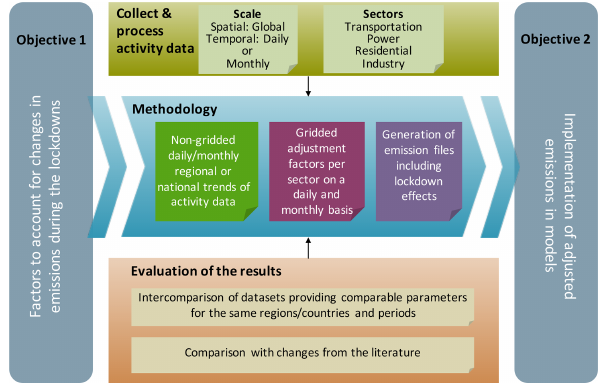
Figure 1. Schematic view of the different steps for estimating the emission adjustment factors